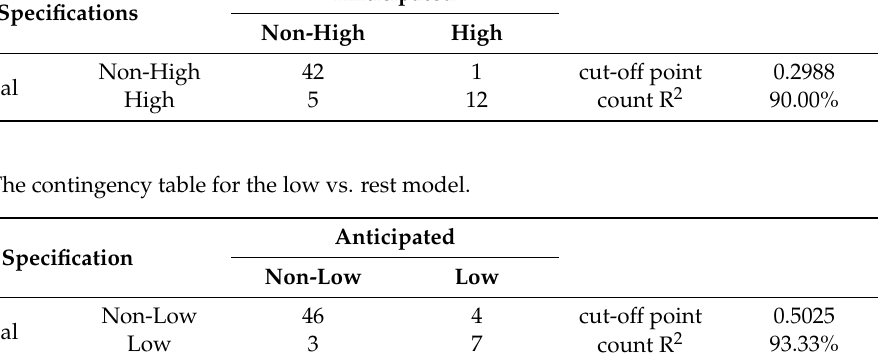
Table 6. The contingency table for the high vs. rest model. Specifications